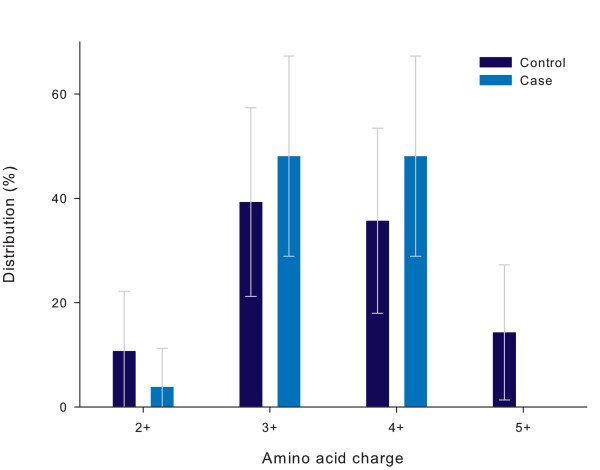
Distribution of V3 amino acid charges per study group. Distribution of the nett charges of the V3 fragment in children with severe anaemia (cases, Hb<5.0 g/dL) as compared to those without severe anaemia (controls). The distribution is expressed as a percentage of the total number of codons analysed per study group (Controls: n = 28, Cases n = 26). Error bars express 95% Confidence intervals. p = 0.19.